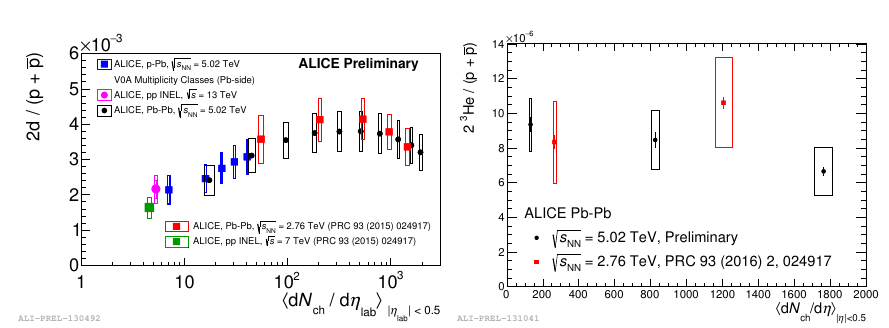
Figure 3. Deuteron (left panel) and 3 He (right panel) over proton ratios as a function of the charged particle multiplicity in the laboratory in di ff erent collision systems. Statistical uncertainties are represented as vertical lines whereas boxes represent the systematic